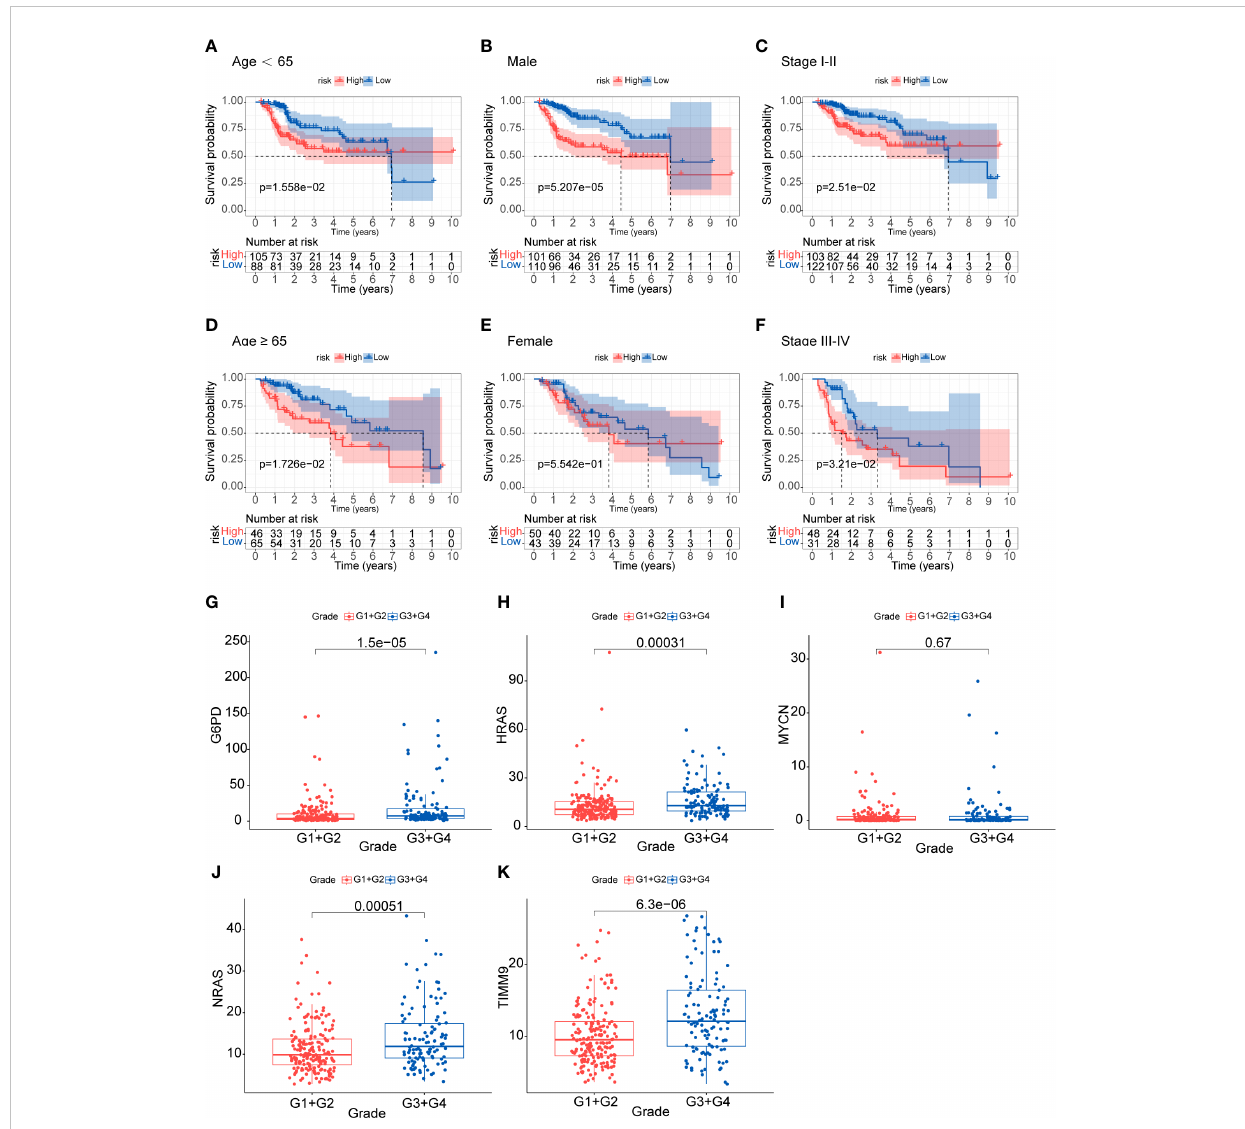
FIGURE 4 Analysis of clinical relevance and risk score (A-F) Analysis of relationship between clinical features and risk score. (G-K) Analysis of the fi ve genes in different tumor